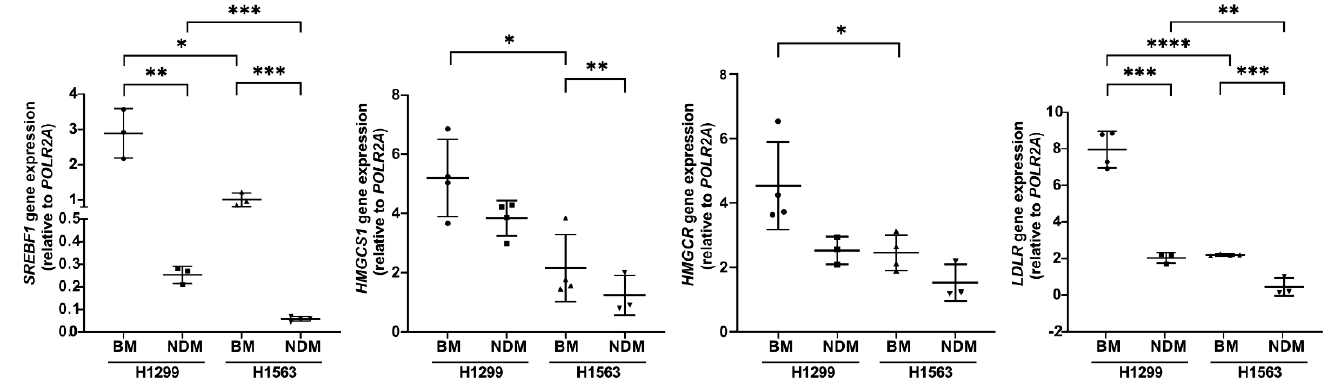
Figure 4. Expression of lipid-related genes in H1299 and H1563 cells cultured in BM and NDM. Cells were incubated in BM or in NDM for 18 h and RNA was isolated and analyzed by real-time qPCR. Data are shown as mean (SD) from n = 3 independent experiments except for SREBF1 H1563 NDM, LDLR H1299 and H1563 BM, HMGCS1 H1299 BM/NDM and H1563 BM, HMGCR H1299 and H1563 BM with n = 4. All analyses were carried out in duplicate. p -values were calculated with a one-way ANOVA. A p -value below 0.05 was considered as significant: * p < 0.05, ** p < 0.01, *** p < 0.001, and **** p < 0.0001. BM, basal medium; NDM, neutrophil degranulation medium.